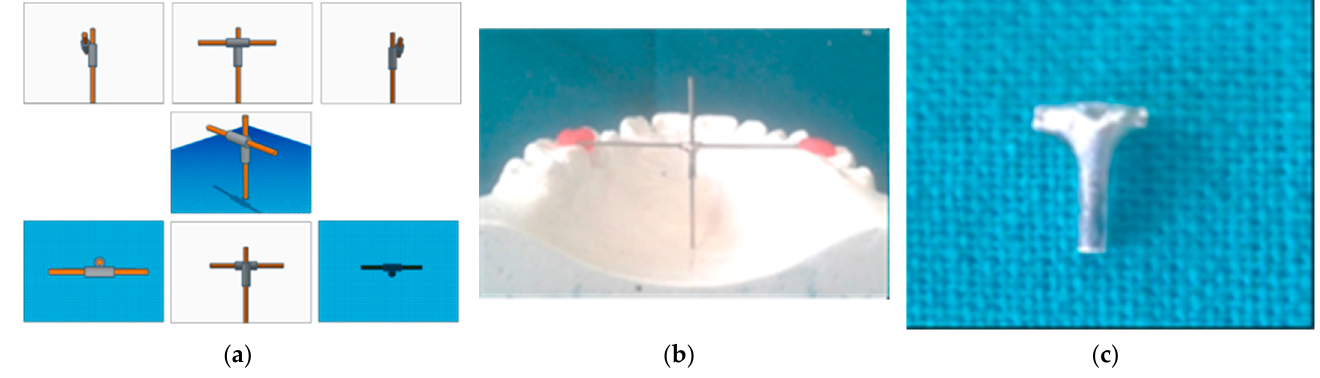
Figure 3. Palatal Depth Measurement Device: ( a ) 3D simulation views- right, front, left, oblique, top, rear, bottom; ( b ) Palatal Depth Measurement Device while taking measurement on study model; ( c ) Closer view of T- shaped assembly alone.